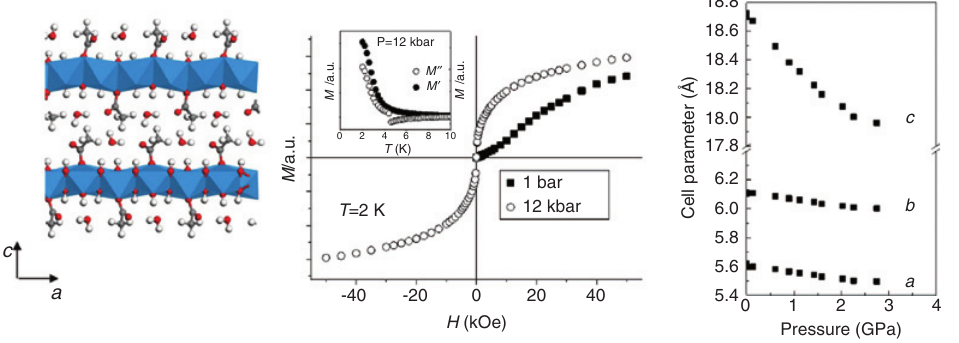
(OH) (CH COO)·H O showing the stacking according to c of the copper(II) hydroxide 2 3 3 2